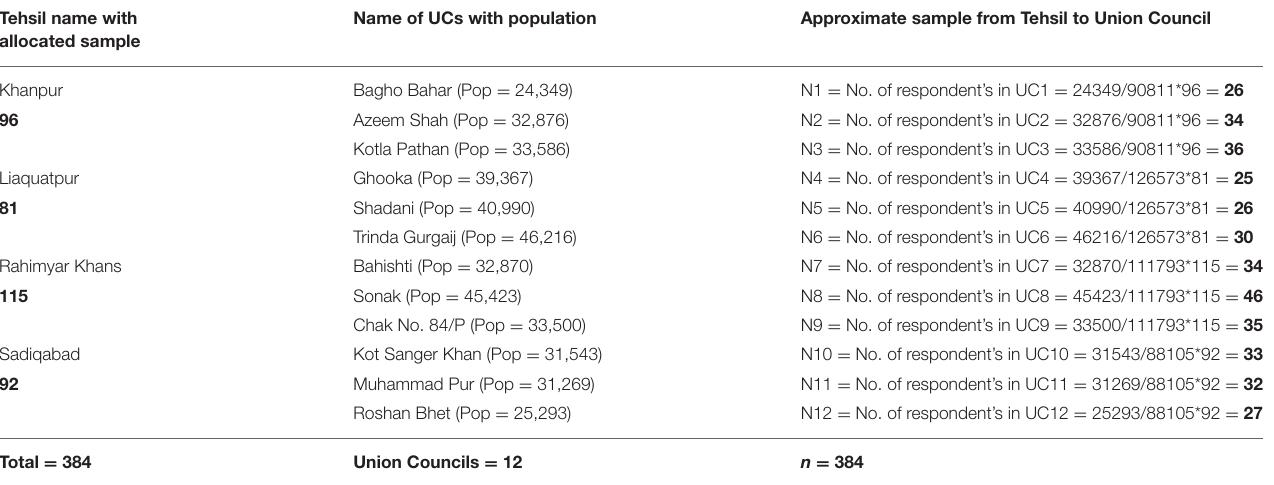
Name of UCs with